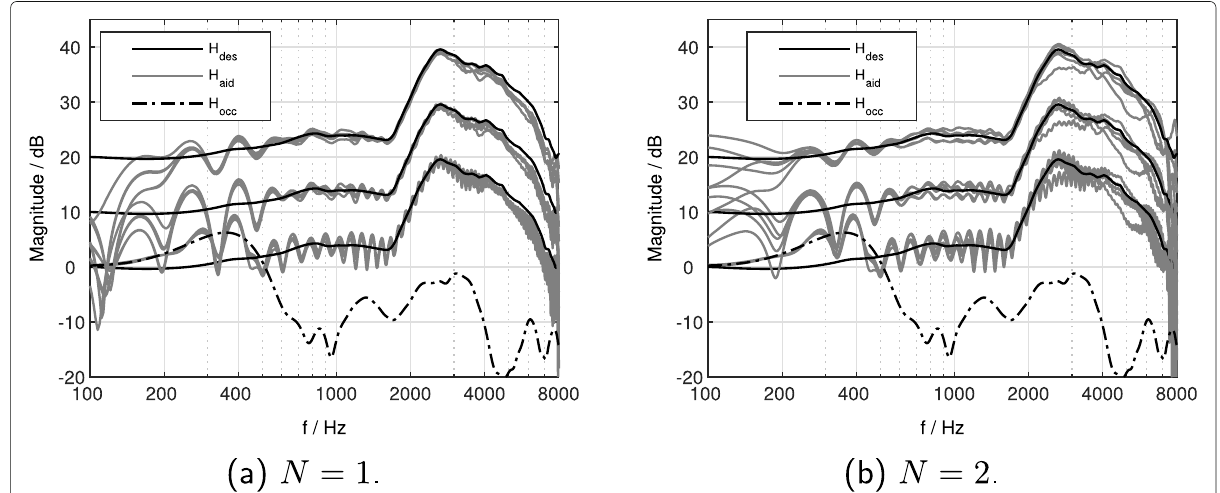
Fig. 9 Magnitude responses of the occluded ear transfer function H occ ( q ) , the desired open ear transfer function H des ( q ) and the aided ear transfer function H aid ( q ) for the robust optimization for different forward path gains G 0 and a N = 1 and b N = 2 ( λ = 0.1, d G = 96, d H = 32, β = 1). The forward path gains are from bottom to top G 0 = 0dB, G 0 = 10dB, and G 0 =